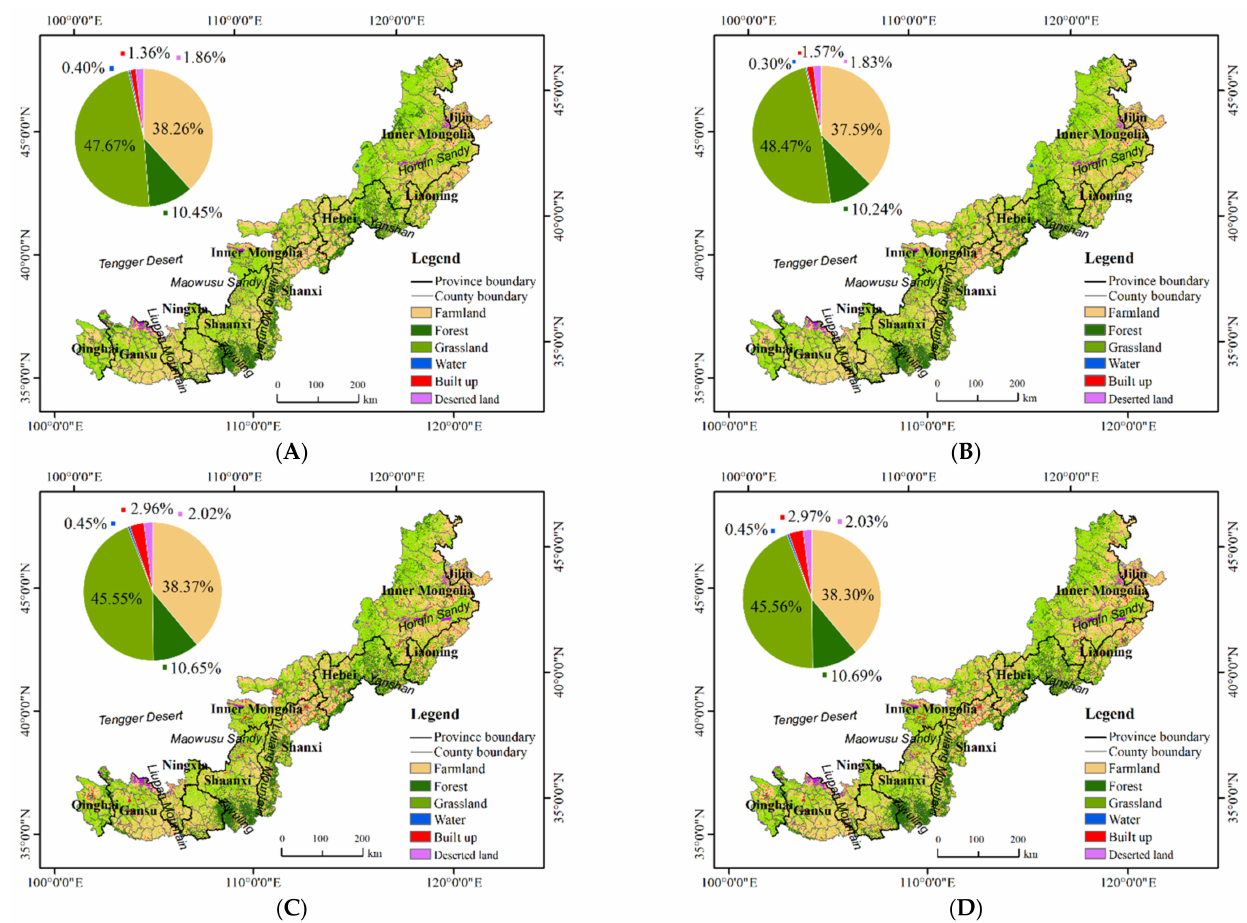
Figure 3. Spatial distribution of land use in the Agro-Pastoral Zone of Northern China from 2000 to 2030. ( A ) 2000; ( B ) 2010; ( C ) 2020; ( D )